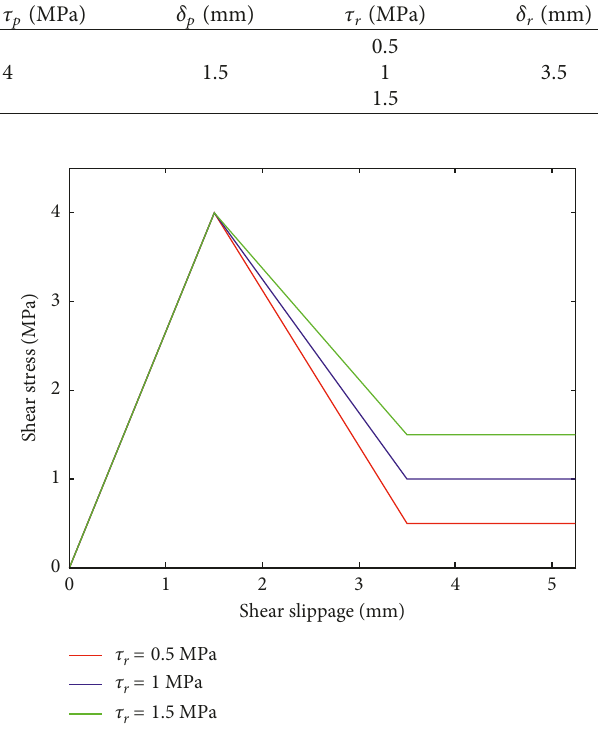
Table 10: Input parameters for the bond-slip model.